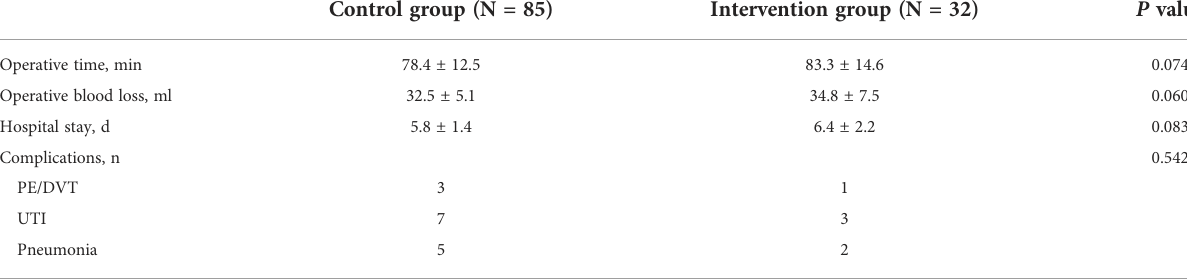
TABLE 3 Comparison of surgery-related outcomes between the two groups.